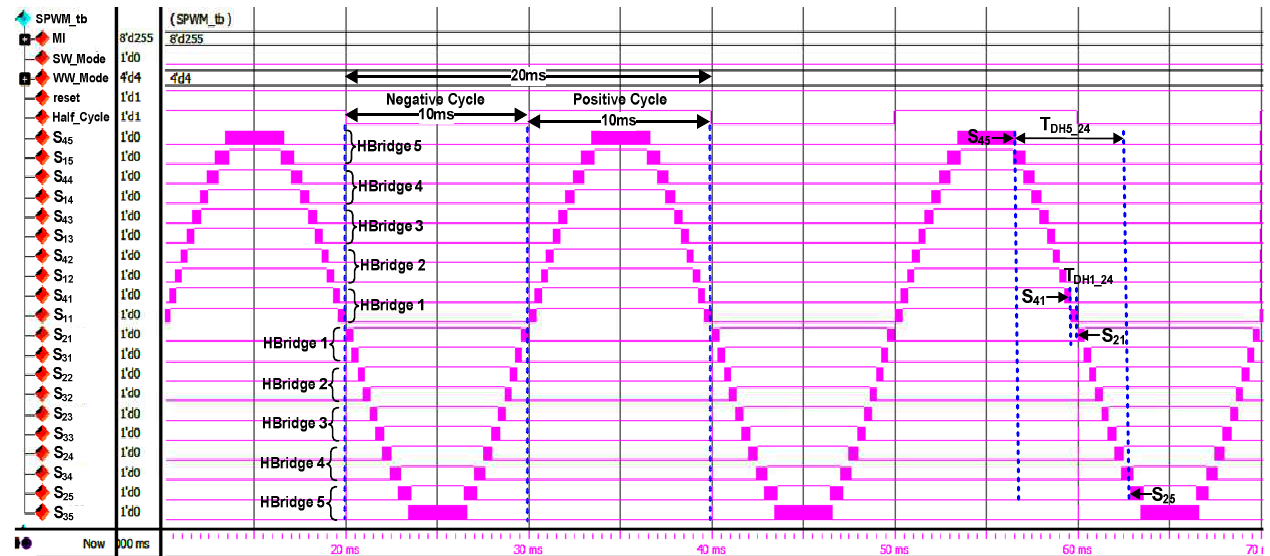
Figure 20. RTL simulation result for the output gating pulses (“S 45 ” to “S 35 ”) of the SPWM digital switching